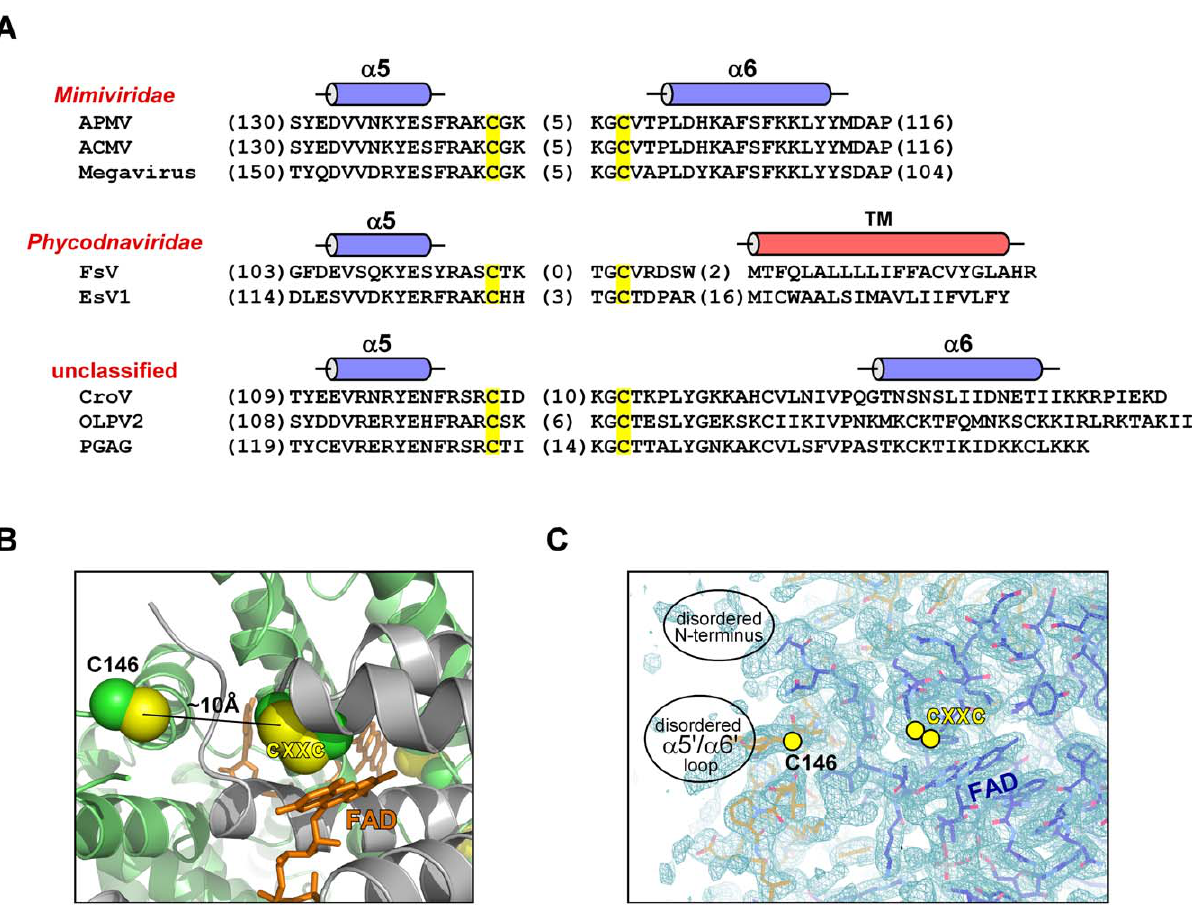
Figure 5. Putative shuttle disulfide in viral sulfhydryl oxidases. (A) Amino acid sequences spanning the putative shuttle disulfide in the sulfhydryl oxidases of mimivirus and related viruses. In parentheses are the numbers of amino acids in the indicated locations not explicitly represented in the alignment. Observed or predicted helices are shown as cylinders. (B) The active-site region of the R596-4C dimer is shown with one subunit gray and the second lime green. The FAD is in orange sticks. The approximate distance between the position of the C146–C156 disulfide and the FAD-proximal cysteines is indicated, with the caveat that C146 is on the edge of a region with extremely poor electron density and its orientation cannot be taken as definitive. (C) 2Fo-Fc electron density contoured at 1.4 s is shown at the protein-solvent boundary, indicating the approximate positions of the disordered amino-terminal region of the protein and the loop bearing the C146–C156 disulfide. Cys156 is not visible in the electron density map, and the position of Cys146 should be taken as approximate.